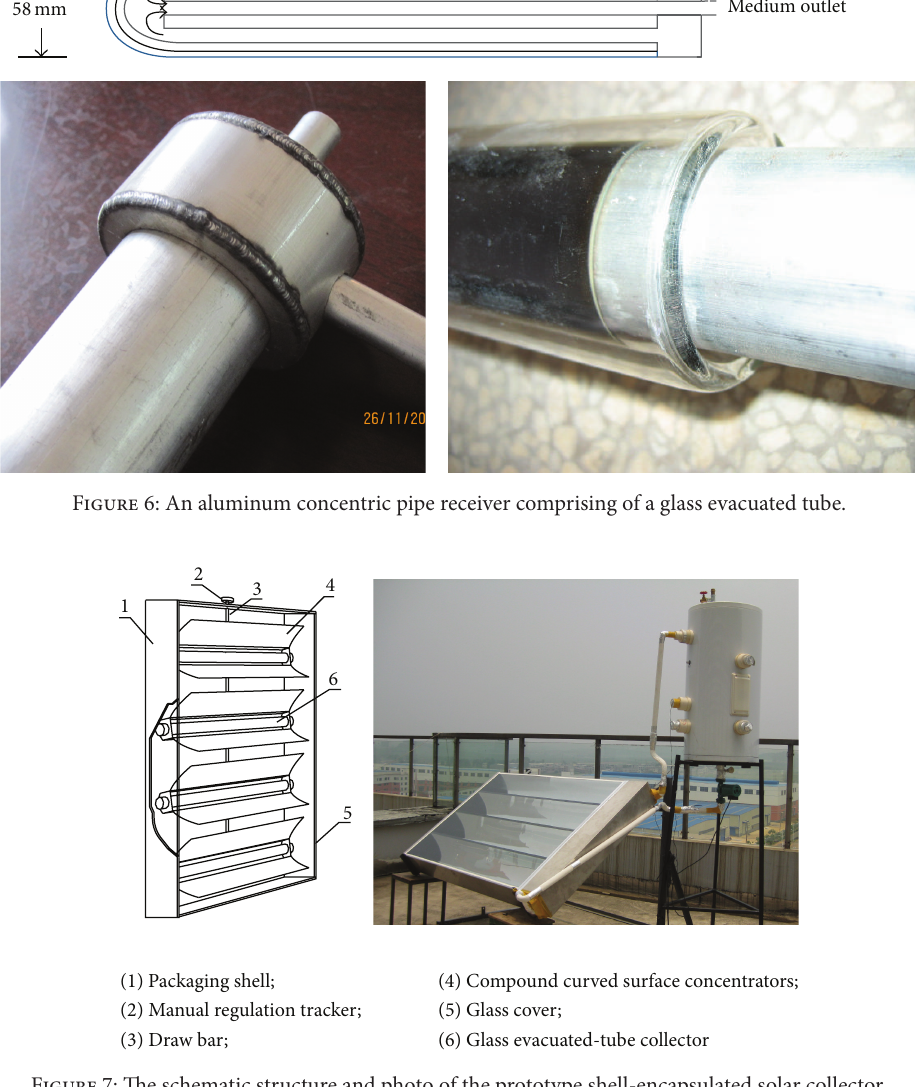
Figure 7: The schematic structure and photo of the prototype shell-encapsulated solar